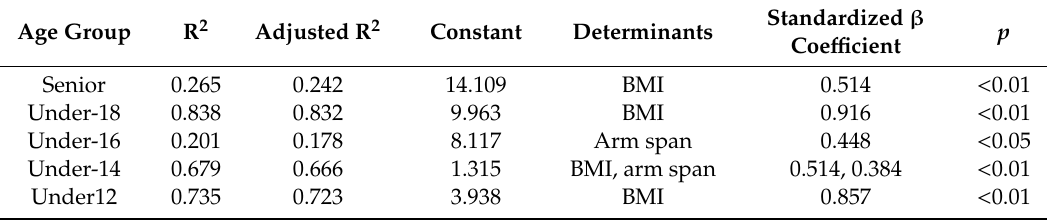
Table 3. Determinants of TS estimated R 2 in di ff erent age groups in male handball